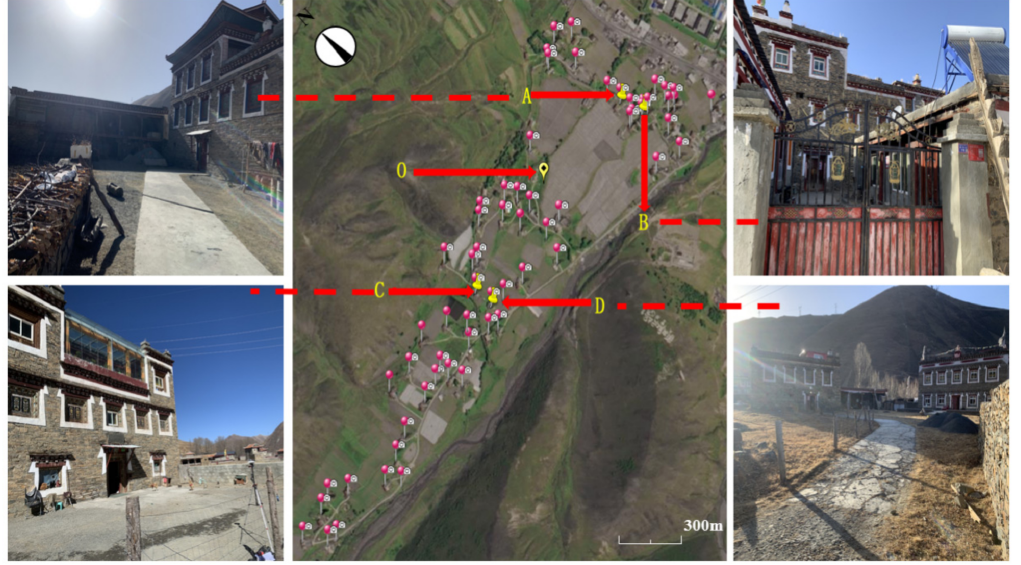
Figure 4. Village survey situation, location of measurement points, and basic situation of courtyards. Based on the classification of courtyard characteristics, this experiment selected four representative courtyards and an outdoor reference point for the comparison and analysis of the actual measurements. During the measurement, the influence of the reflectivity of different materials on the courtyard’s thermal environment, the internal architectural details, and the materials in the courtyard were organized and recorded (Table 1). Table 1 shows that the main building materials inside the courtyard are all stone masonry, which eliminates the influence of the building materials on the main building inside the courtyard in this actual measurement. (Reflectivity of main materials in the courtyard: Dry bare land 0.1–0.2, Dry lawn 0.15–0.25, Concrete floor